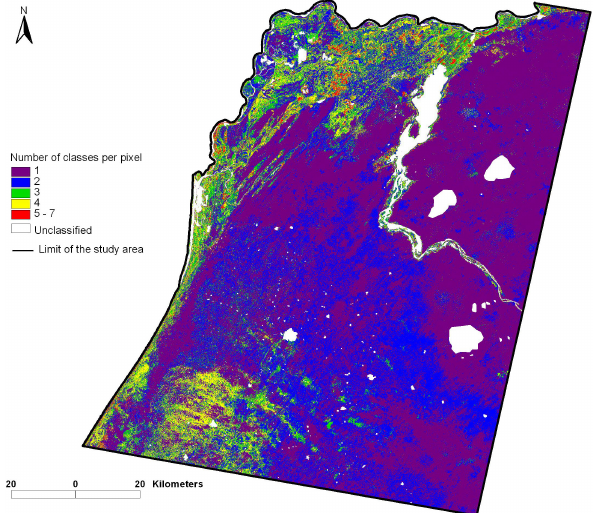
independently classified as over the 30 decision tree classification runs is shown. Pixels